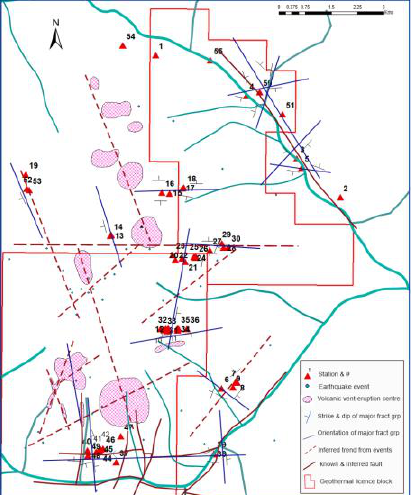
Figure 12. Orientations of major tectonic features interpreted from volcanic eruption center/vents, recorded earthquakes, and known and inferred faults from geophysical data and fracture strike groups. Figure modified from [50].